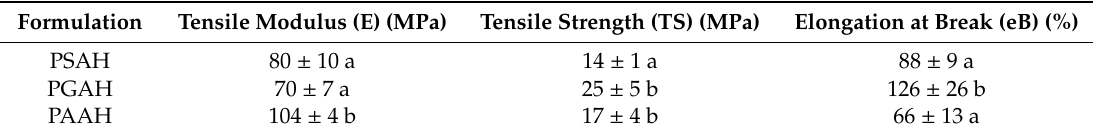
Table 4. Mechanical properties of PVA crosslinked films